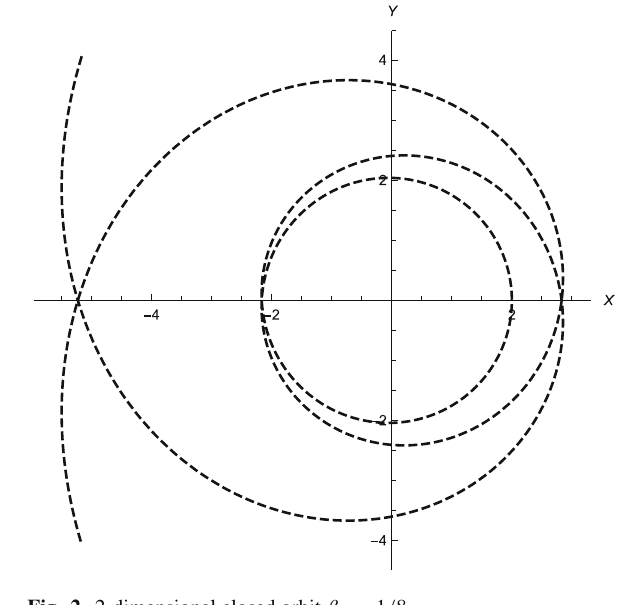
Fig. 2 2-dimensional closed orbit β 0 = 1 / 8